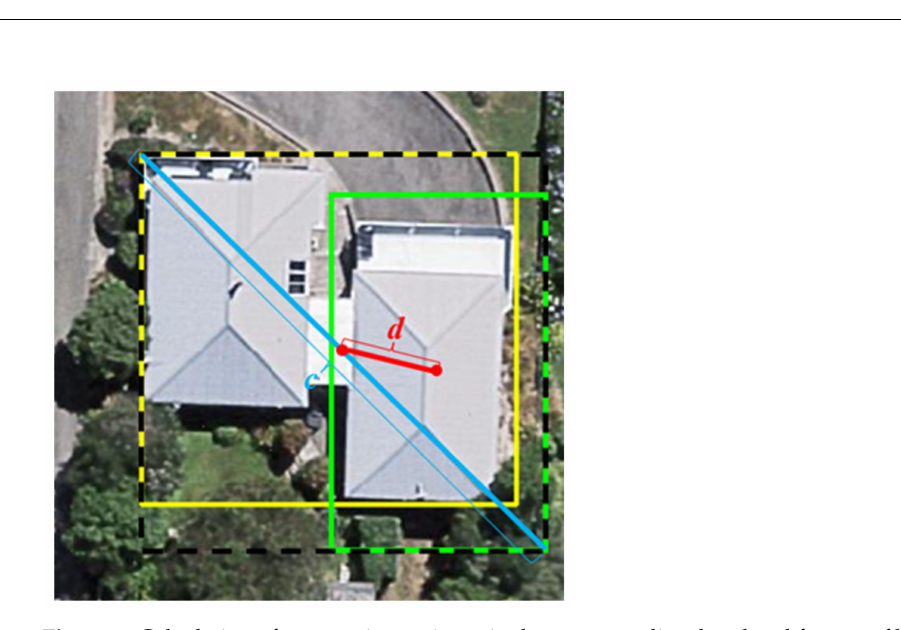
Figure 4. Calculation of geometric consistencies between predicted and real frames of